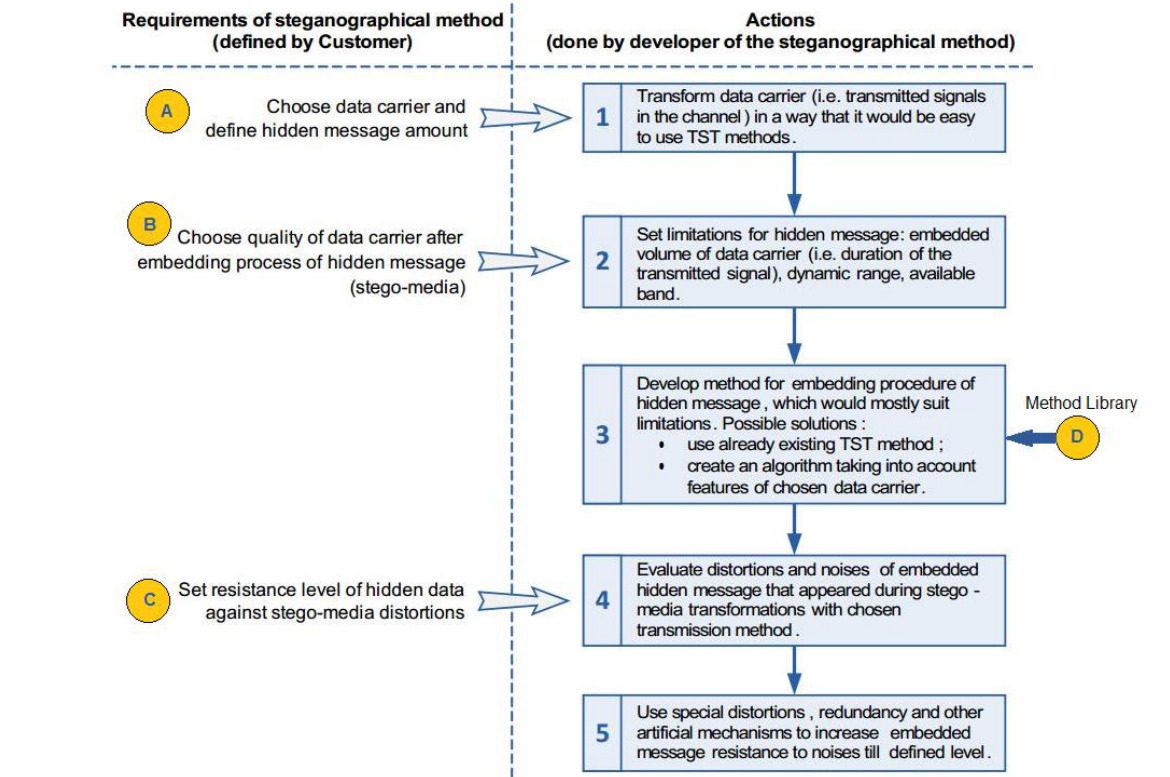
Fig. 6. The concept of the Universal Stegoconstructor [25] modified with the inputs from the approach introduced in the present research (A, B, C,